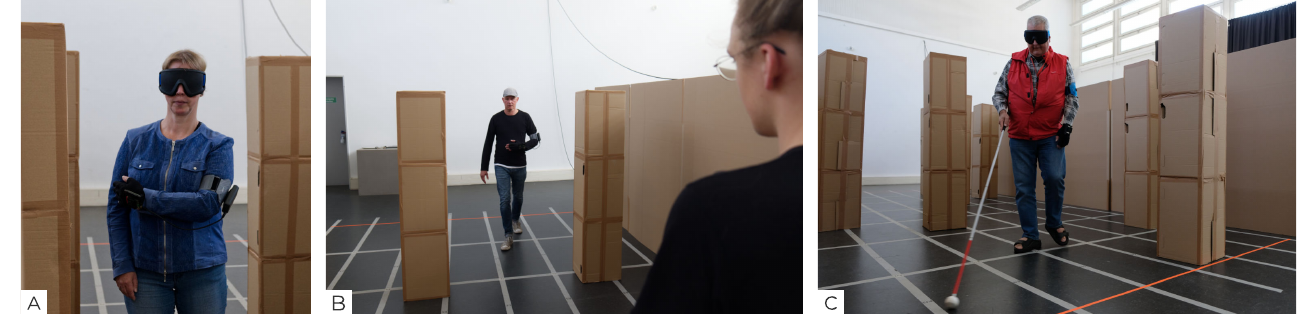
Figure 4. ( A ) A subject practising with the SSD in the tutorial at the beginning of the study ( B ) A typical task in the practice sessions: passing a gap between two obstacles ( C ) A sighted subject training with the cane during a practice